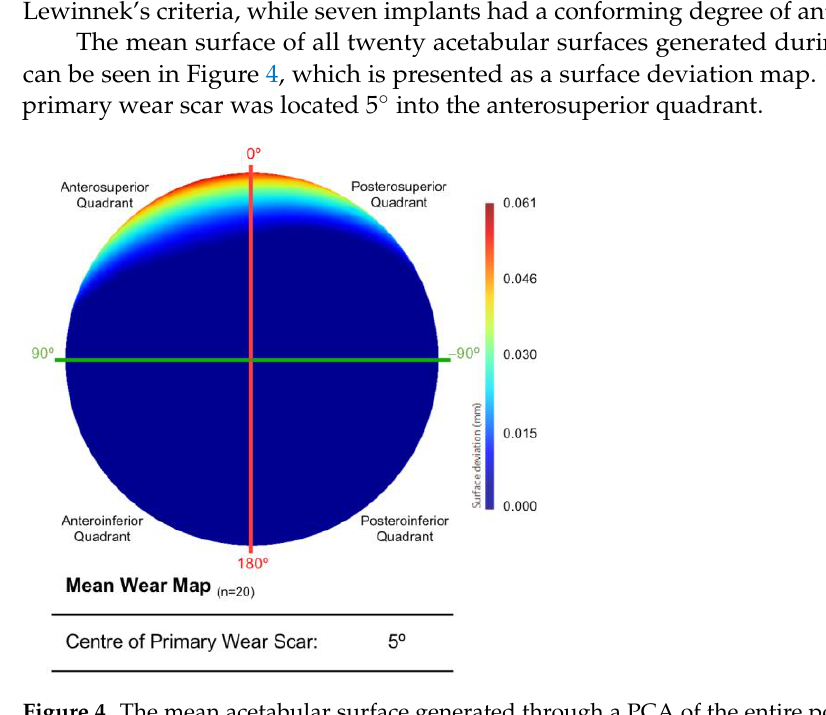
Figure 4. The mean acetabular surface generated through a PCA of the entire population (n = 20). This is presented as deviation map of their comparison with the as-manufactured reference surface, where the dark blue regions are considered unworn (mm).